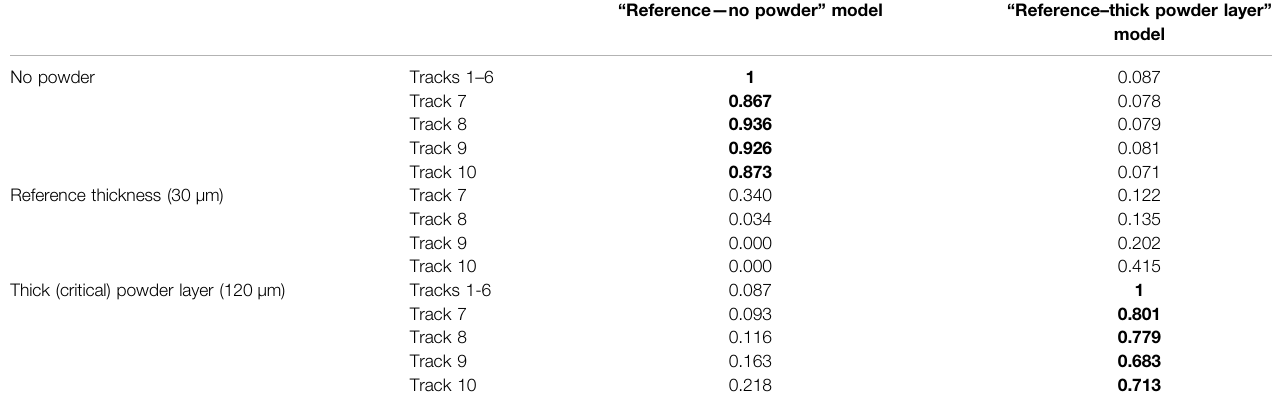
TABLE 1 | Correlation coef fi cients for experiments with single tracks. The values in bold are the that should correspond to that column i.e., data should correlate to that column.